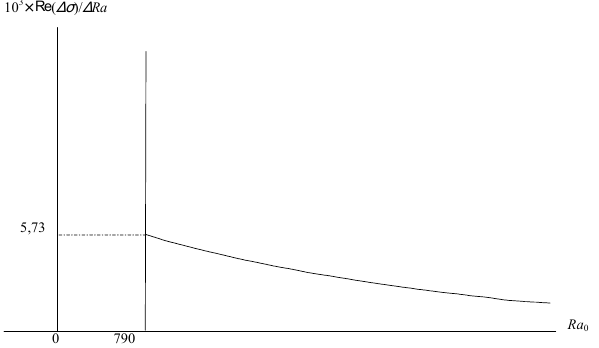
Fig. 4. Growth rate of the oscillatory most unstable mode. The x - axis is taken along the oscillatory threshold, the variable being the moist Rayleigh number R h 0 . The numerical values are the same as in Fig. 1. When R a 0 → ∞ , R e(1σ)/1R h → 0 as R a 0 − 1